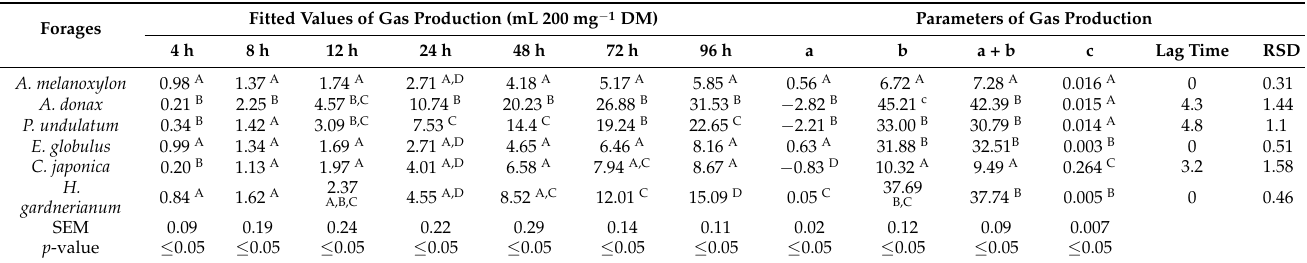
Means within a column with different capital letters differ significantly, p -value significant at p ≤ 0.05.a: gas production from the immediately soluble fraction (mL); b: gas production from the insol- uble fraction (mL); a + b: potential gas production (mL); c: the gas production rate constant for the insoluble fraction (mL/h); lag time expressed in hours.